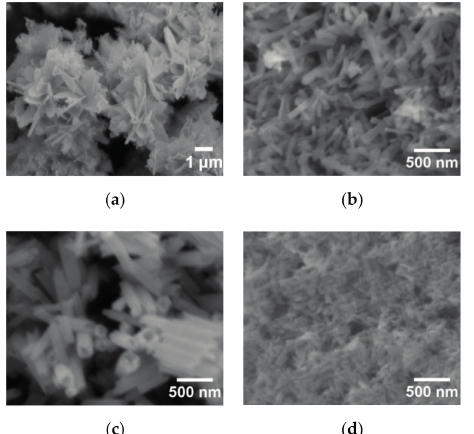
Figure 5. SEM images of the products obtained at 80 ◦ C for 24 h as a function of the pH value of the starting solution. The pH value used is 7.34 ( a ), 9.24 ( b ), 10.82 ( c ), 12 ( d